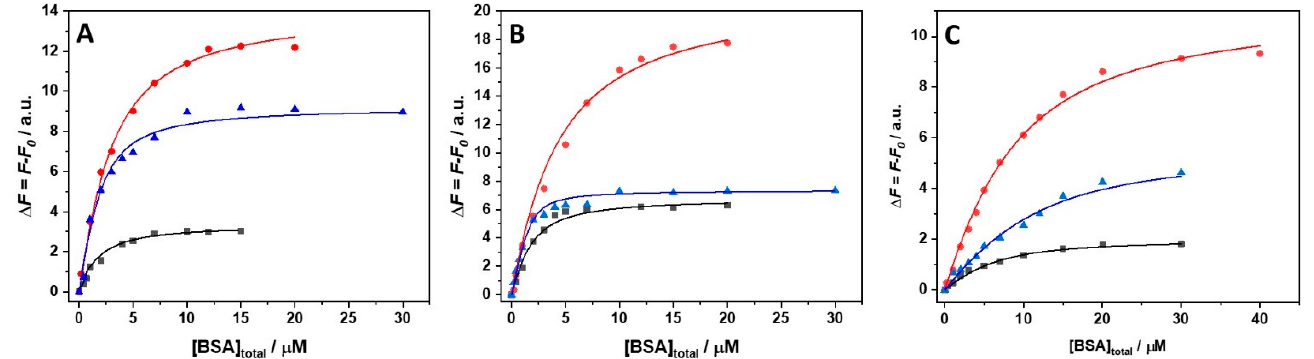
Figure 2. Binding isotherms for complex formation between the bovine serum albumin (BSA) and 8-anilinonaphthalene-1-sulfonic acid (ANS) obtained at the temperatures of 5 °C (black squares), 15 °C (red circles), and 25 °C (blue triangles) at p = 1 bar in the presence of 250 mM ( A ) MgCl 2 , ( B ) MgSO 4 , and ( C ) Mg(ClO 4 ) 2 . The solid lines represent the best fit of experimental data according to an equivalent and independent binding sites model for the experiments performed in the presence of MgCl 2 and MgSO 4 , and to two classes of independent binding-sites models for the experiments carried out in the presence of Mg(ClO 4 ) 2 . The binding isotherms were obtained by plotting Δ F = F − F 0 (where F is the fluorescence intensity of ANS at the maximum in the presence of BSA, and F 0 is the intensity of ANS in the absence of BSA) as a function of total BSA concentration.